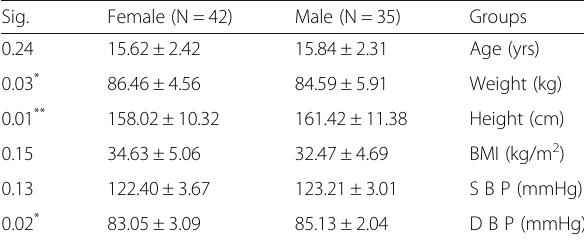
Table 1 Mean ± SD of Age, Weight, Height and BMI, of obese adolescent under the study Sig. Groups